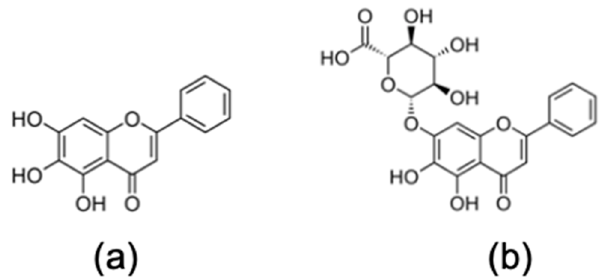
Figure 1. Chemical structures of ( a ) baicalein and ( b ) baicalin.